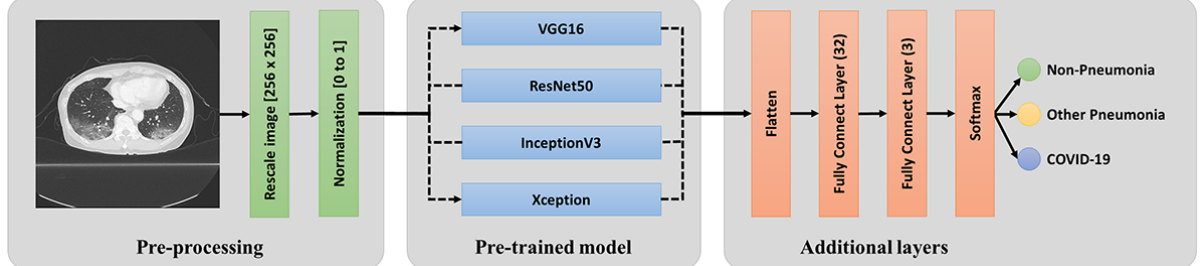
Figure 1. Scheme of FCONet, a 2D deep learning framework based on a single chest CT image for the classification of COVID-19 pneumonia, other pneumonia, and non-pneumonia. COVID-19: coronavirus